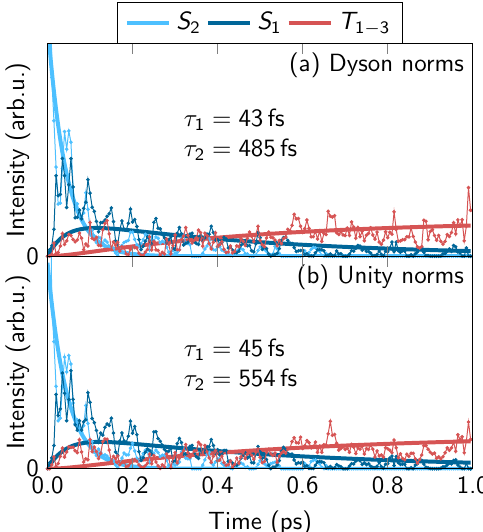
Figure 7. Integrated TRPES yields decomposed by state ( S 2 , S 1 , T 1 the obtained time constant from fits with a three-component sequential kinetic model. Note that, in the fit, we assumed identical intensities for S 1 and T , based on the experimental intensities and the fact that the total yields are almost